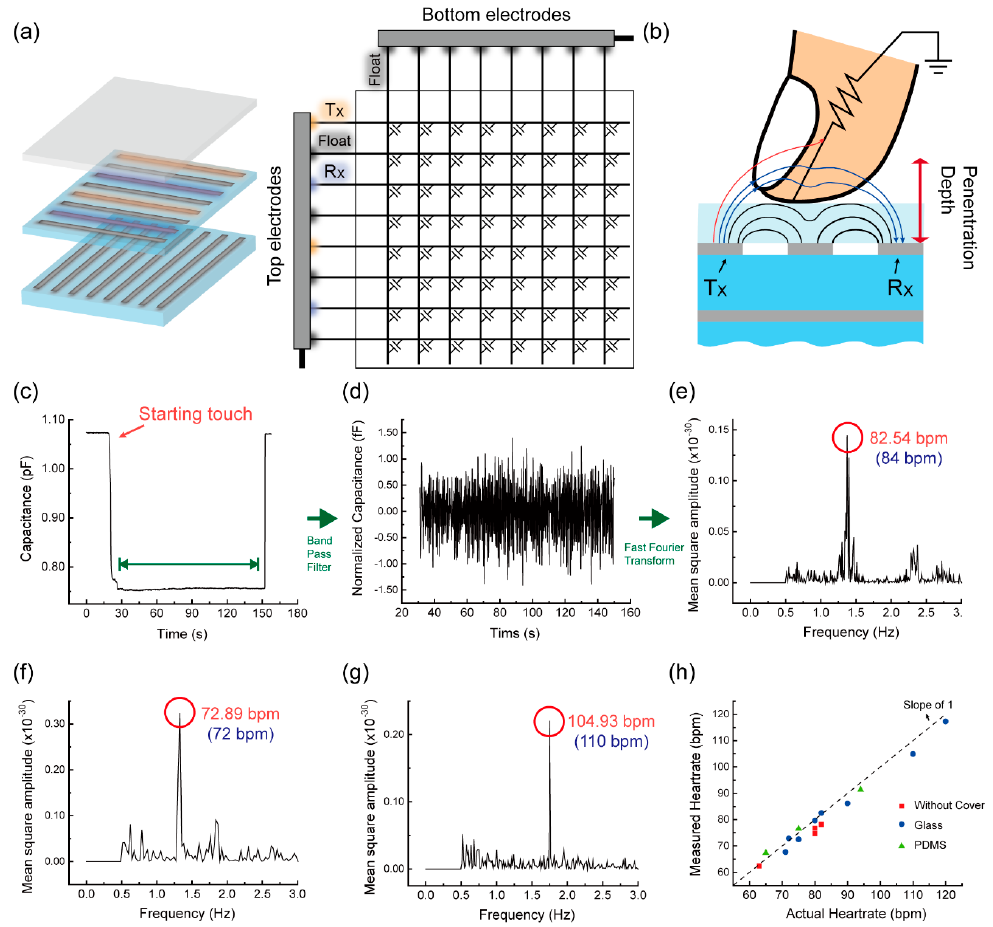
Figure 5. Schematic view of ( a ) electrode / circuit configuration and ( b ) the operational principle of TSP for heart-rate sensing with cover glass. The red lines represent the electric field lines lost to the finger and the blue lines indicate the electric field lines going through the finger. ( c ) Capacitance change when a finger touches the surface of cover glass, ( d ) normalized capacitance after going through band pass filtering (0.5–3.0 Hz), and ( e ) frequency spectrum obtained from FFT. Frequency spectra of the capacitance data measured ( f ) for another person and ( g ) after exercise. The values inside the parentheses of ( e – g ) are the heart-rates counted directly on the wrist. ( h ) Correlation between capacitively-measured and directly-counted heart-rates for no cover layer, glass cover layer, and PDMS cover layer.